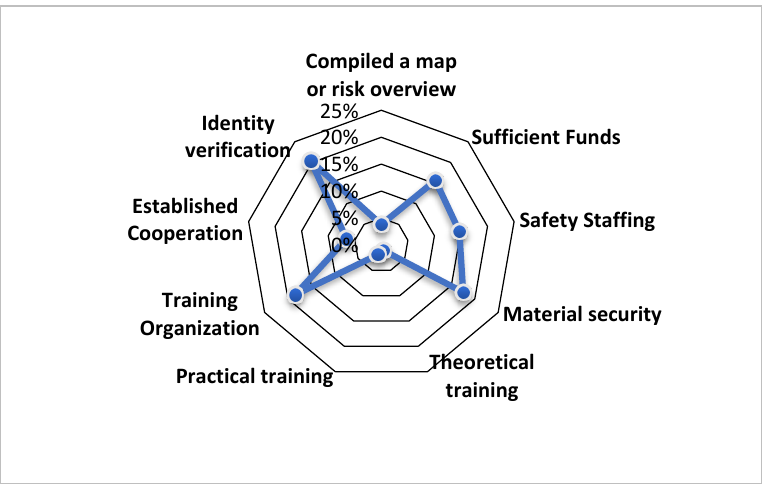
Figure 7. The causes of the inadequate level of school security. Source: own.